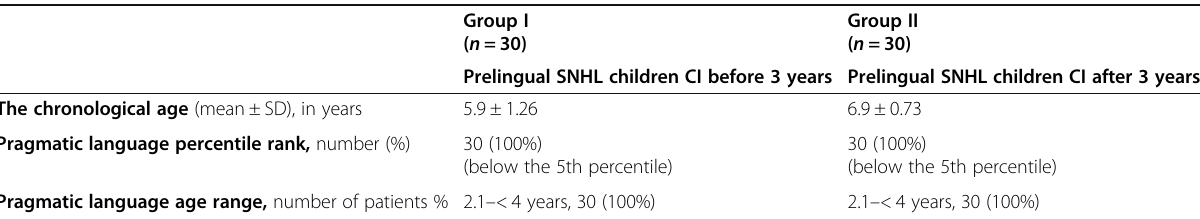
Table 4 Ranks of percentile of the total score of the Egyptian Arabic pragmatic language test (EAPLT) and the pragmatic language age range among the 2 studied